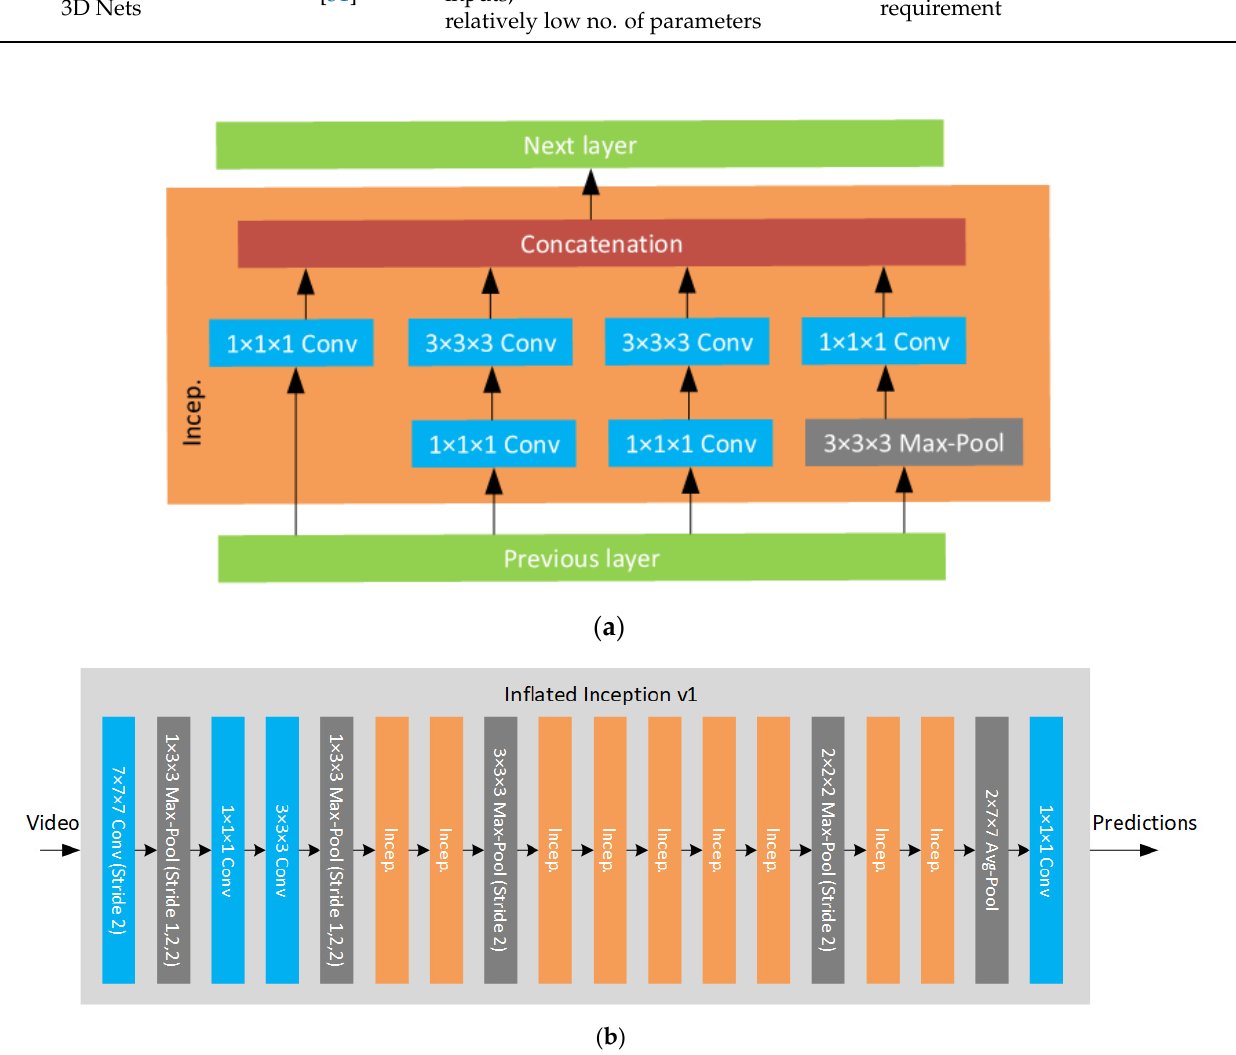
Figure 4. ( a ) Inception module; ( b ) Inflated Inception v1 architecture [35].